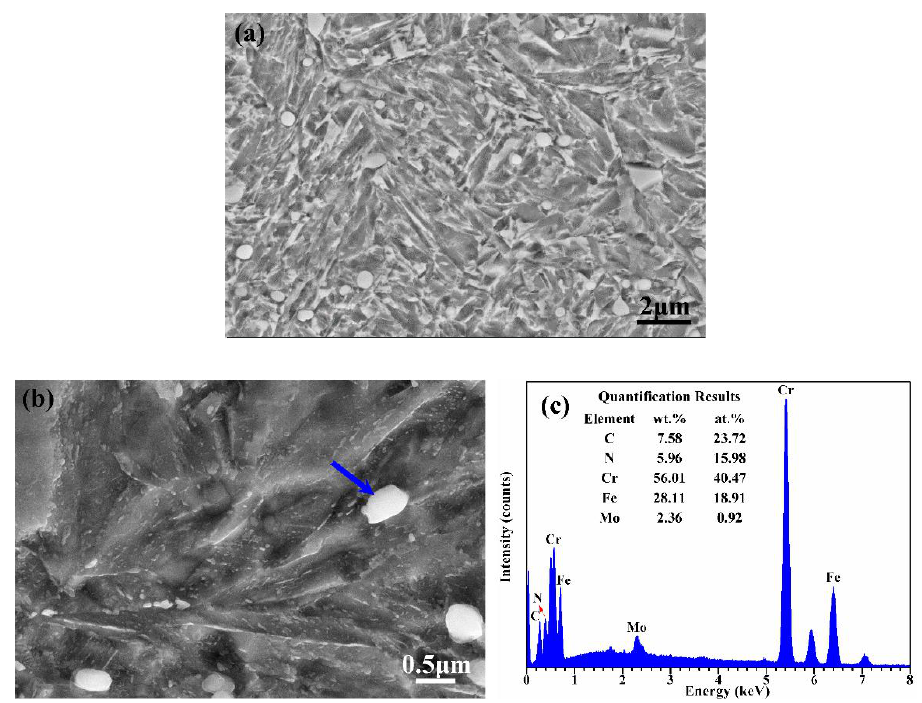
Figure 3. SEM micrograph of ( a ) base material; ( b ) magnified BM and ( c ) its corresponding EDS analysis (the measurement point is indicated by an arrow).